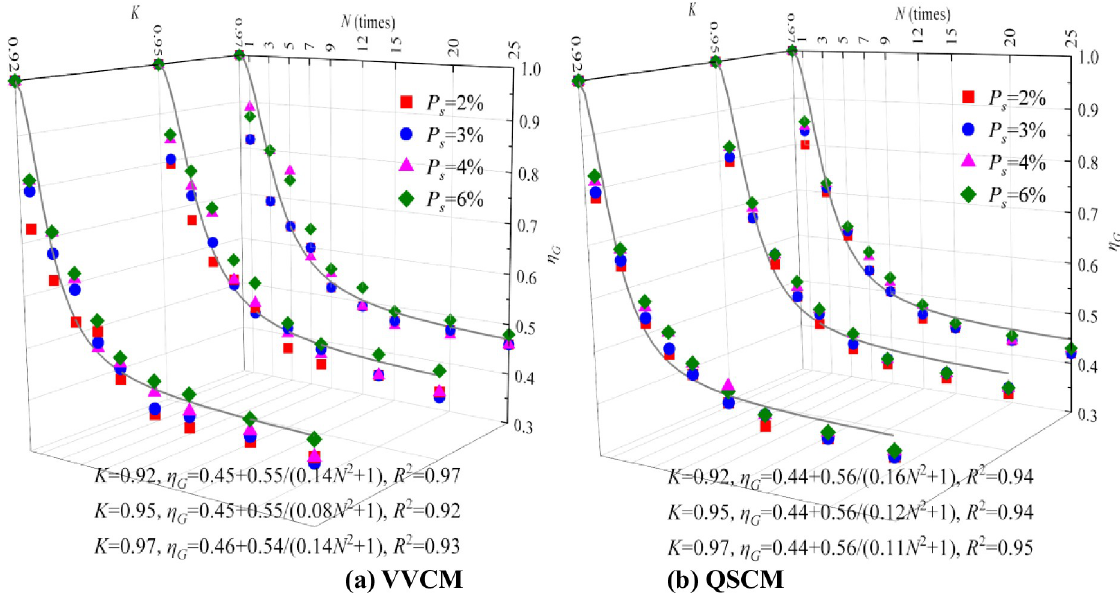
Fig 2. Strength degradation equation of CIL with different K after dry–wet